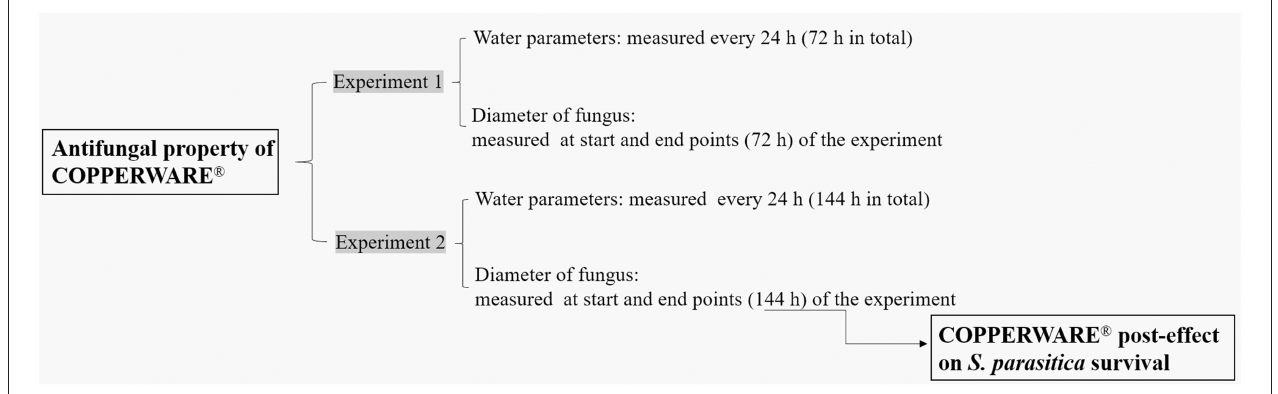
FIGURE 1 | The flow chart of the CCCSNs filter (COPPERWARE ® ) filtration experiments.